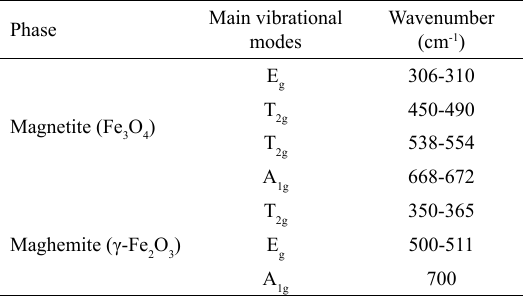
Table 1. Raman main vibrational modes of magnetite and